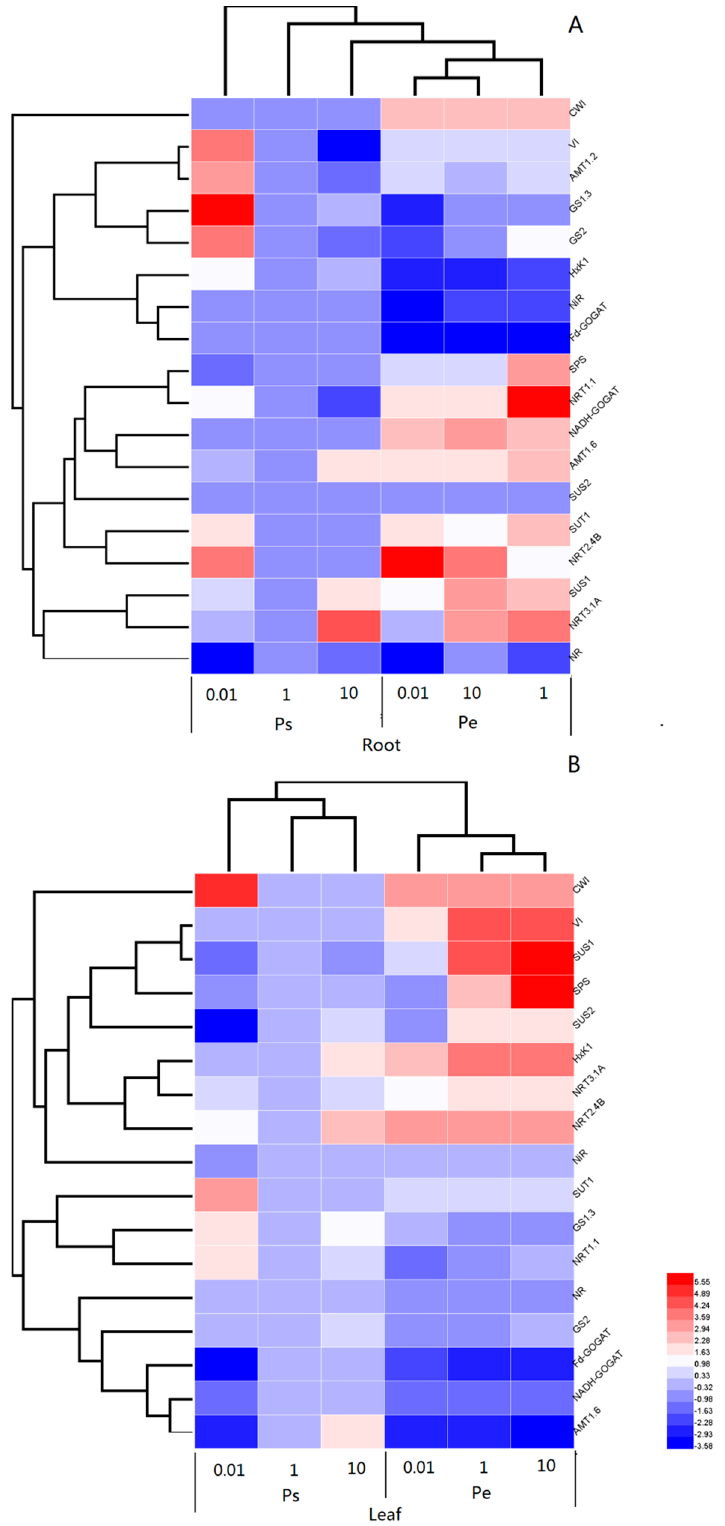
Figure 9. Cluster analysis of transcriptional fold-changes of key genes involved in N uptake and assimilation in roots ( A ) and leaves ( B ) of P. simonii (Ps) and P. euramericana (Pe) under 0.01, 1, and 10 mM NH 4 NO 3 . The colour scale indicates fold-changes of mRNAs. For each gene, the expression levels in roots or leaves of Pp exposed to 1 mM NH 4 NO 3 were defined as 1, and the corresponding fold-changes under 0.01 and 10 mM NH 4 NO 3 were calculated.